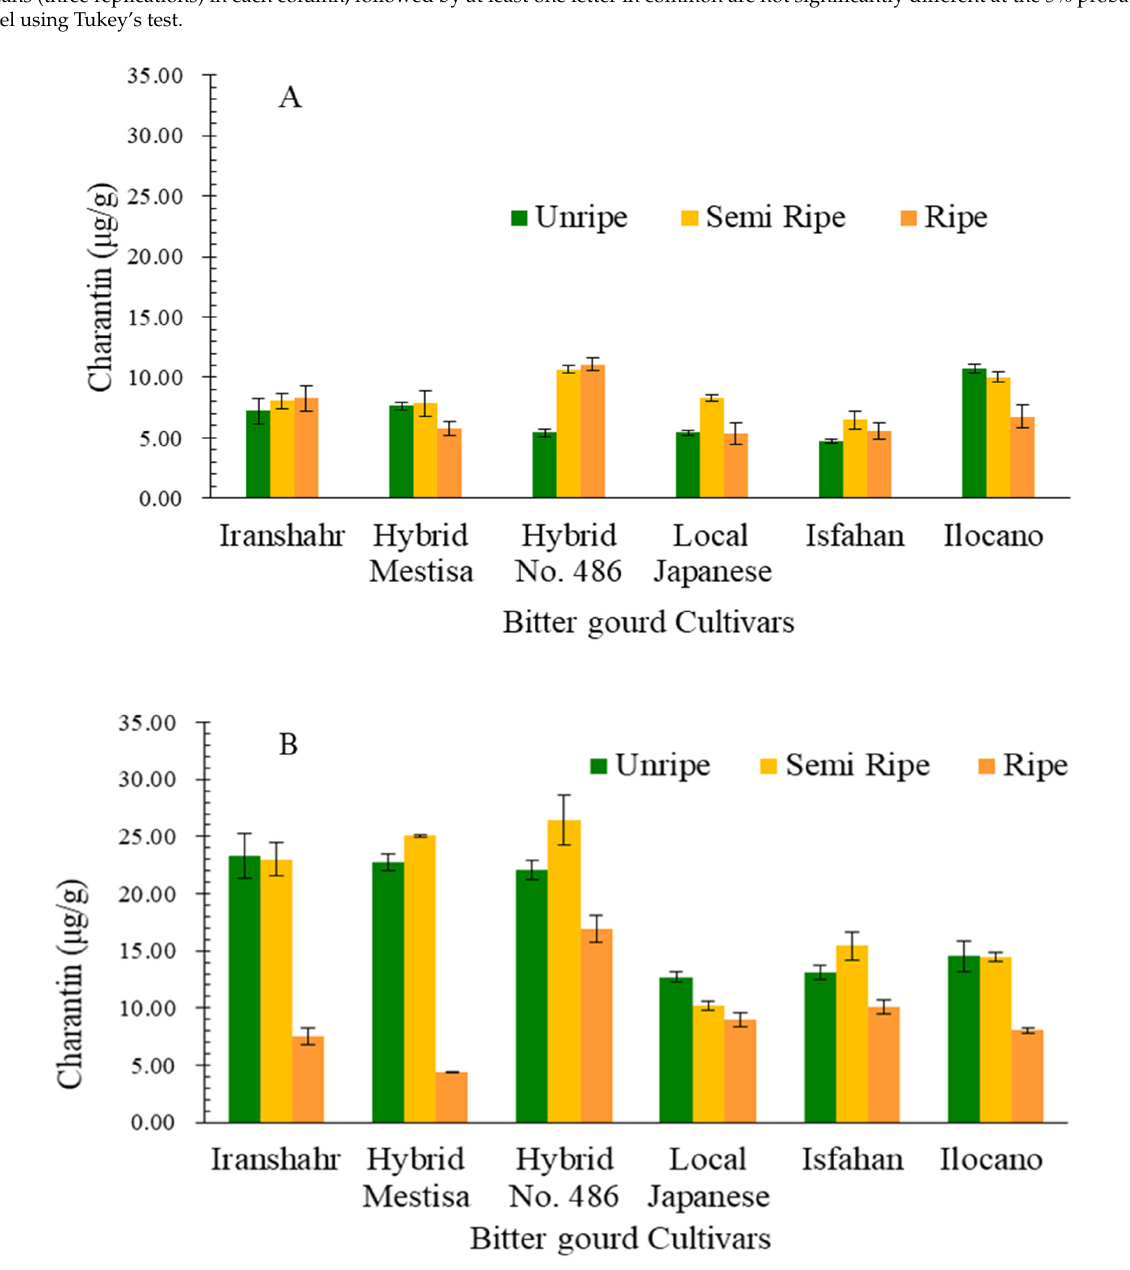
Figure 3. Fruits charantin content in six bitter melon cultivars during different developmental stage and drying condition ( A) : shade-dried, ( B ): freeze-dried. Table 9. Cultivar × drying method and cultivar × development stage interaction effects on fruit charantin content ( μ g/g). Cultivars